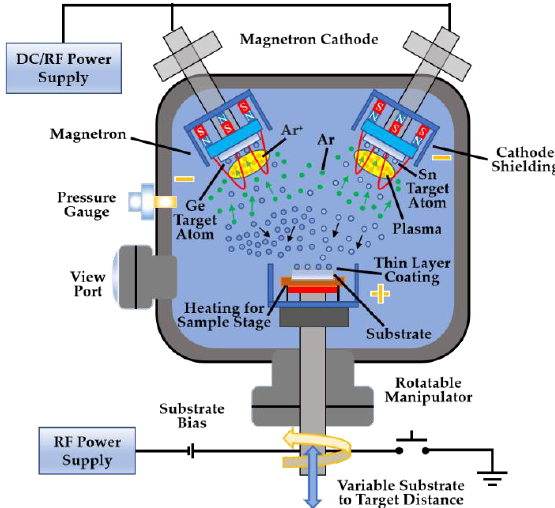
Figure 1. Ge 1-x Sn x co-sputtering schematic diagram. Figure 1. Ge 1 − x Sn x co-sputtering schematic diagram.